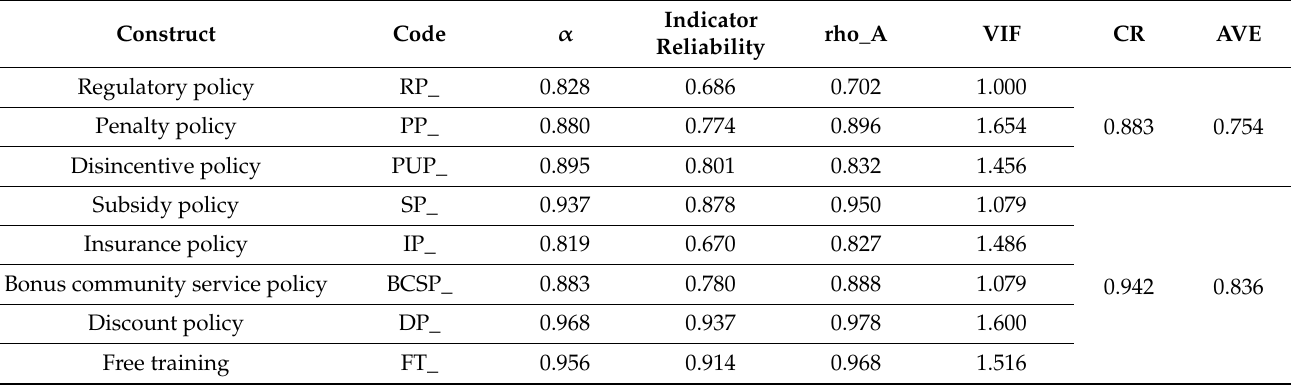
Table 4. Validity of constructs (reflective outer